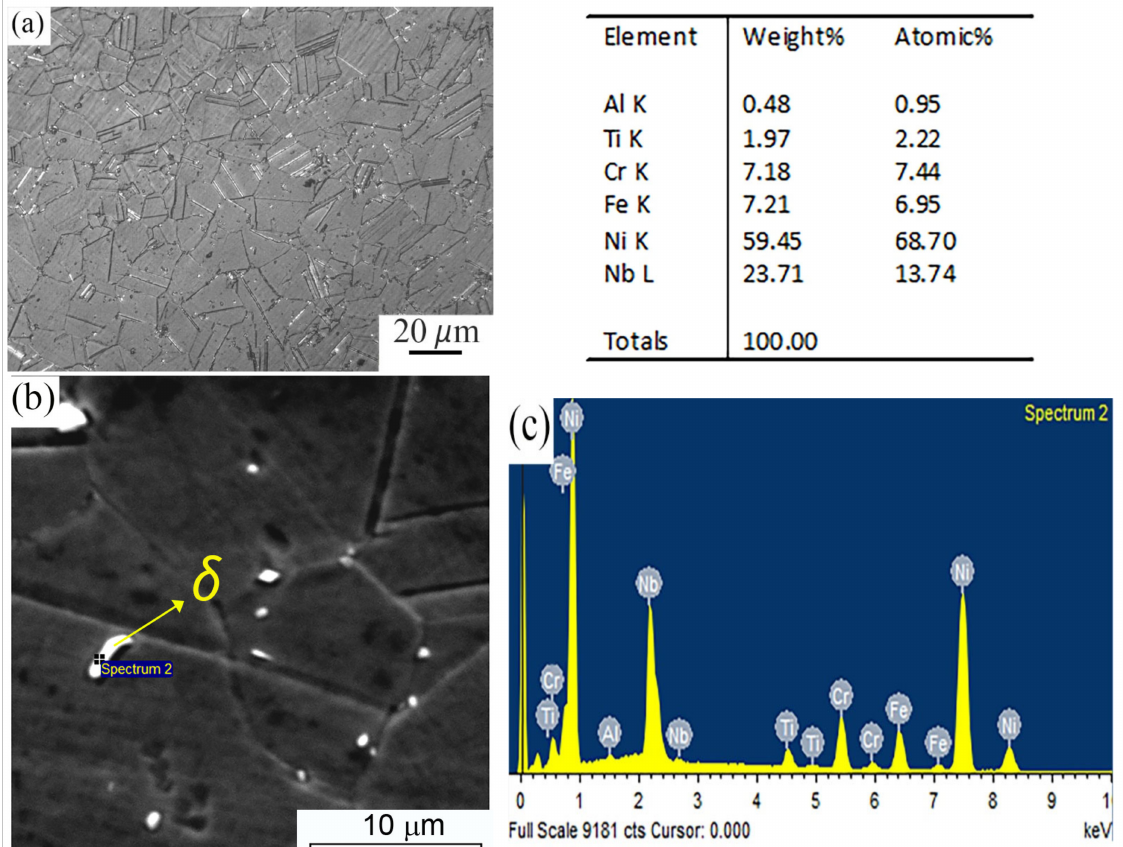
Figure 4. ( a ) Optical micrograph of the IN718 solution-treated (ST) base metal, ( b ) SEM micrograph showing ծ -based precipitates, and ( c ) a typical EDS precipitate spectrum .